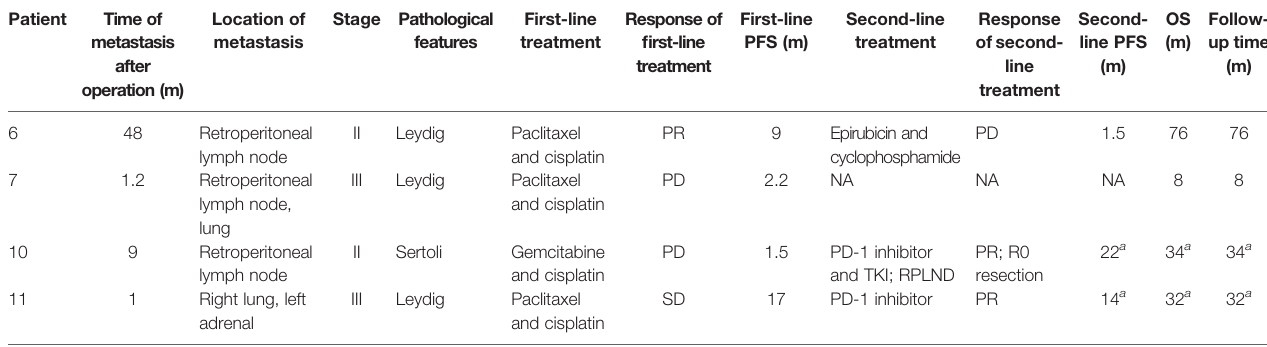
TABLE 3 | Treatments and survivals of 4 patients with metastatic testicular sex cord stromal tumours. Patient Time of metastasis after operation